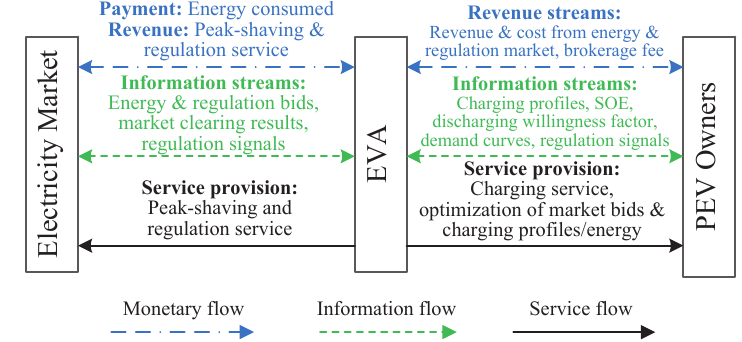
Figure 1. Structure of the proposed business